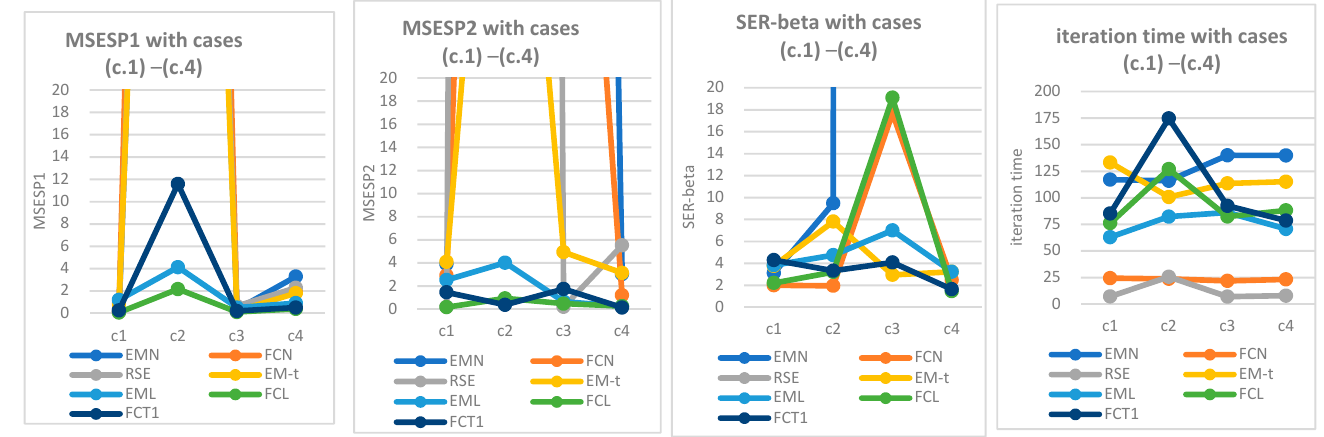
Figure 4. MSE of the switch-point and regression estimates for Model (c) under scenarios (c1)–(c4). In summary, the proposed switching regression model assuming Laplace distributed errors was much more resistant than normal-based models when atypical observations or heavy-tails were present in the dataset. Embedding the fuzzy clustering was helpful for promoting the ability of the algorithm in resisting contaminations. The proposed FCL worked well whether or not data were in the presence of abnormal observations. In par- ticular, FCL generally performed better than the existing methods for providing less bi- ased estimates of SPs and fewer mean square errors of fitted regression models for models